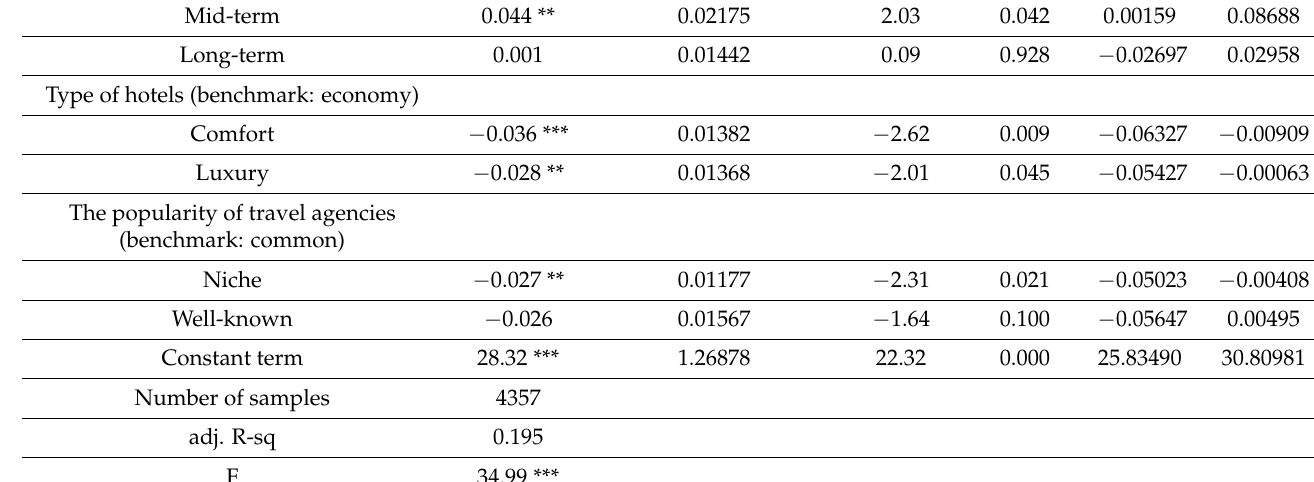
The popularity of travel